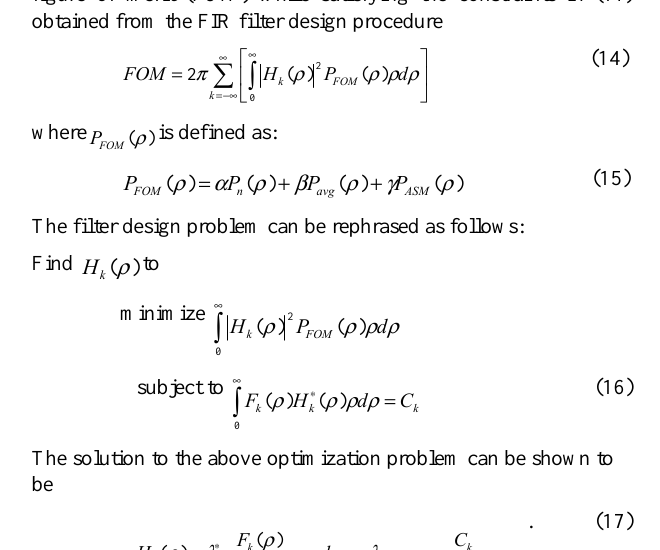
figure of merit (FOM) while satisfying the constraints in (11) obtained from the FIR filter design